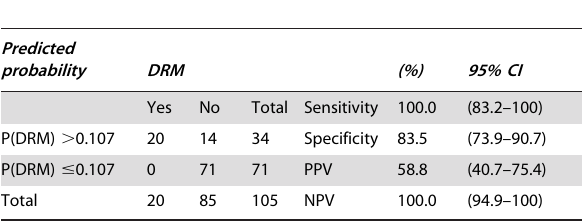
Table 1. Contingency table with results of model validation with 95% confidence intervals for sensitivity, specificity and predictive